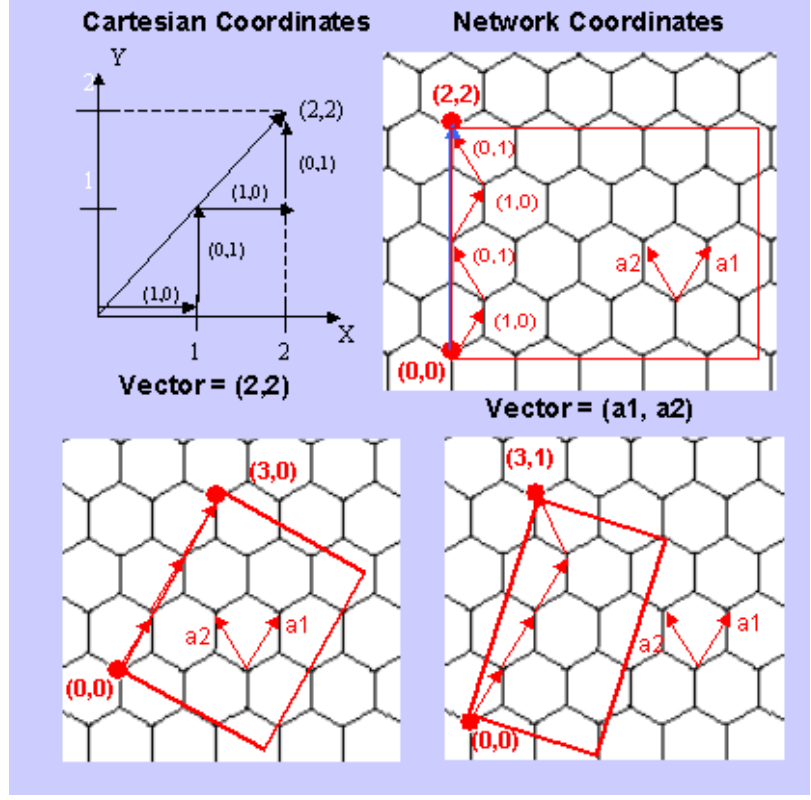
Figure 4. Schematic representation of parameters defining NT diameter and